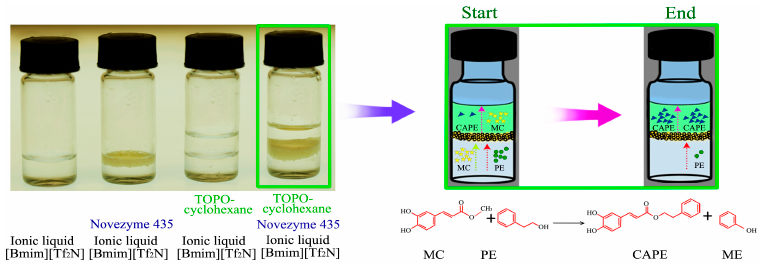
Figure 1. A biphase system of trialkylphosphine oxide (TOPO)-cyclohexane/[Bmim][Tf 2 N] for lipase-catalyzed synthesis of caffeic acid phenethyl ester (CAPE) from methyl caffeate (MC) and 2-phenylethanol (PE) via transesterification.